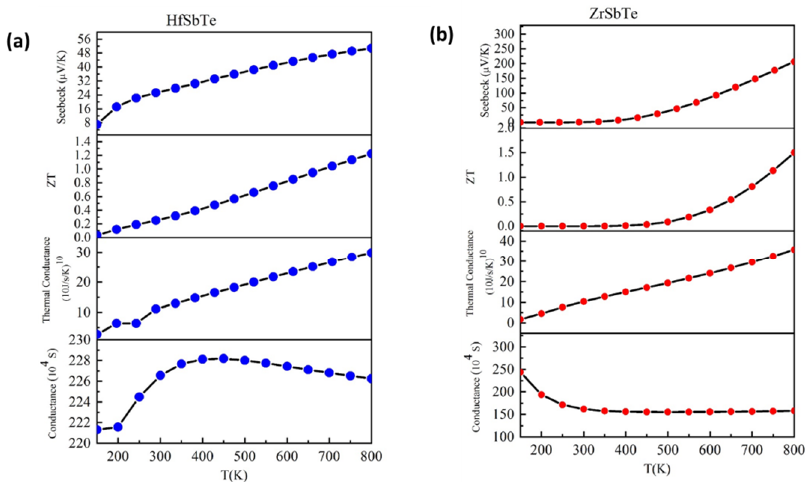
Figure 4. Thermoelectric properties of ( a ) HfSbTe, ( b ) Figure 4 . Thermoelectric properties of ( a ) HfSbTe, ( b ) ZrSbTe.